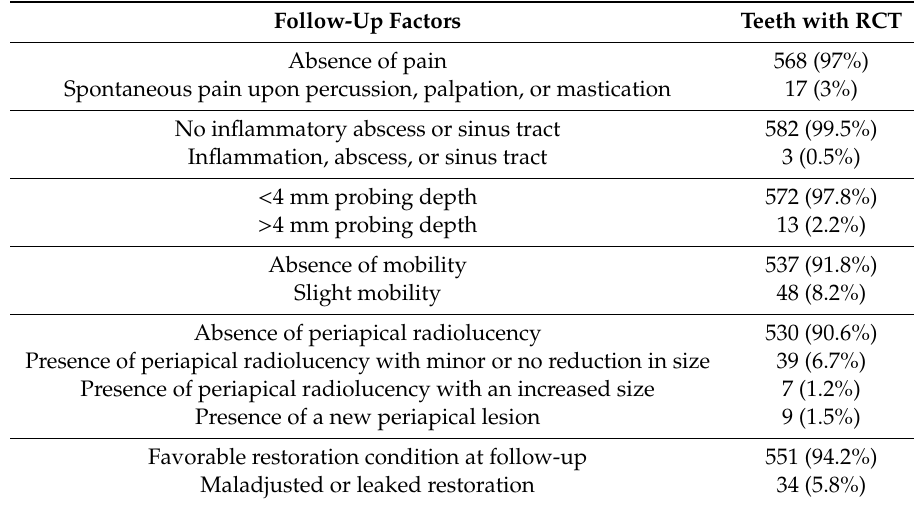
Table 3. Absolute values and percentages of teeth which presented clinical or radiographic factors at the follow-up